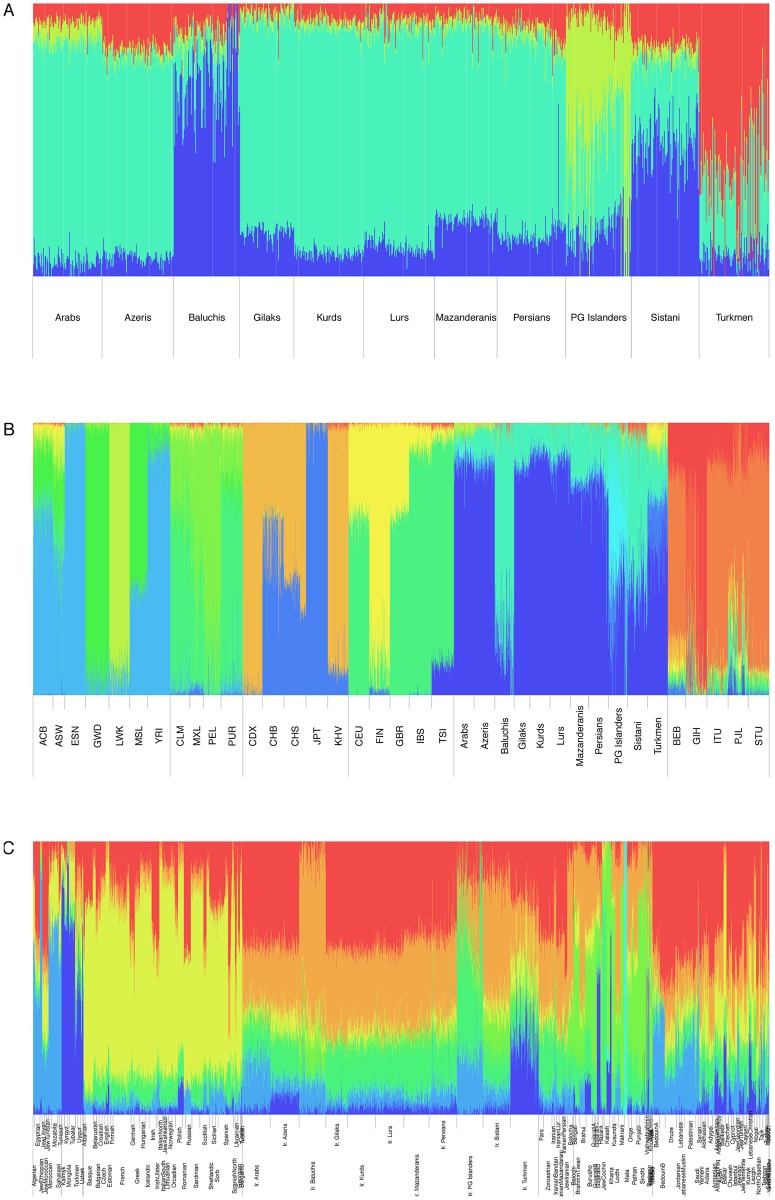
ADMIXTURE inference of Iranian ethnic groups.(A) Inference in Iranian data set. Inferred mixture proportions for 1021 Iranian samples from this study for k = 4 ancestral populations, yielding a minimal cross-validation (CV) error of 0.544; (B) Inference in global data set. Additional inclusion of the global 1000G data set (k = 13; CV = 0.499). (C) Inference in local data set. Additional inclusion of the local data set (k = 8; CV = 0.575).